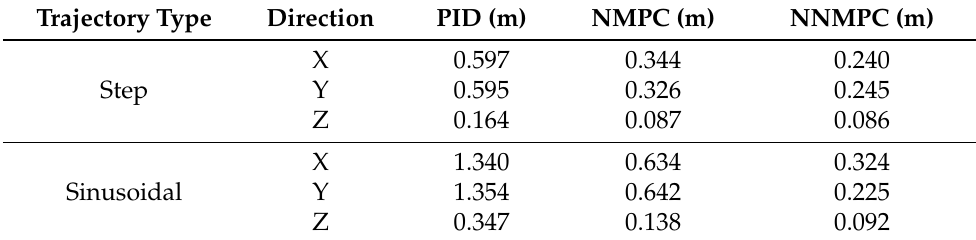
Figure 7. Sinusoidal trajectory tracking result for PID, NMPC, and NNMPC controllers in three axes from simulation. Table 1. RMSE of Trajectory Tracking from Simulation